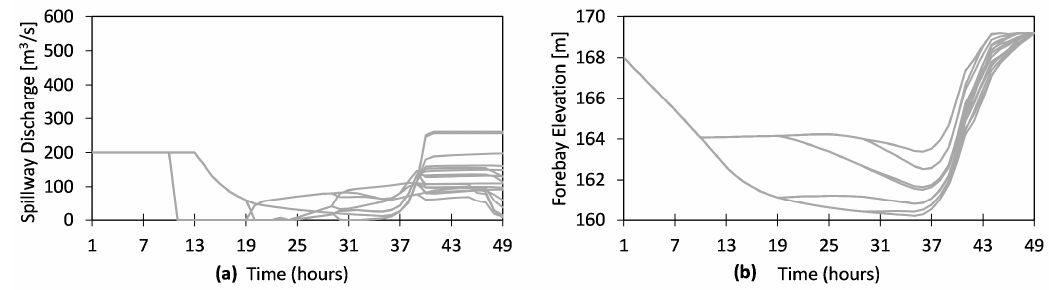
Figure 9. Open-loop optimization results of multi-stage stochastic optimization (from Sce-Q100a): ( a ) Spillway discharge trees (m 3 /s); ( b ) Forebay elevation trees (m).